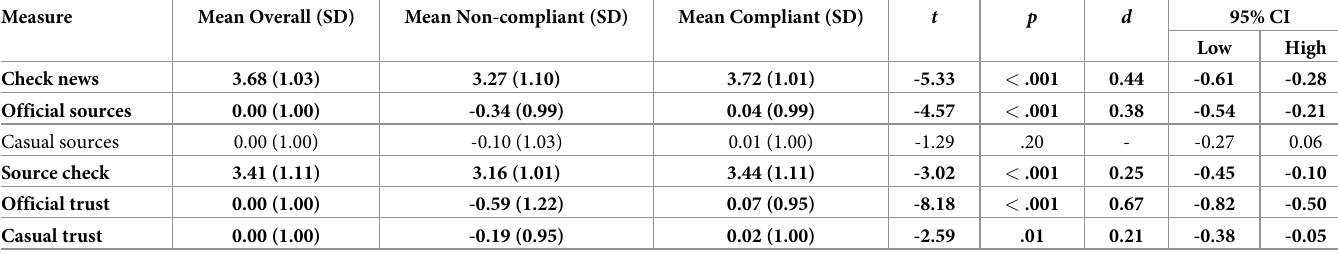
Table 6. Independent samples t-tests on the difference between classes on information consumption (df = 1573). Measure